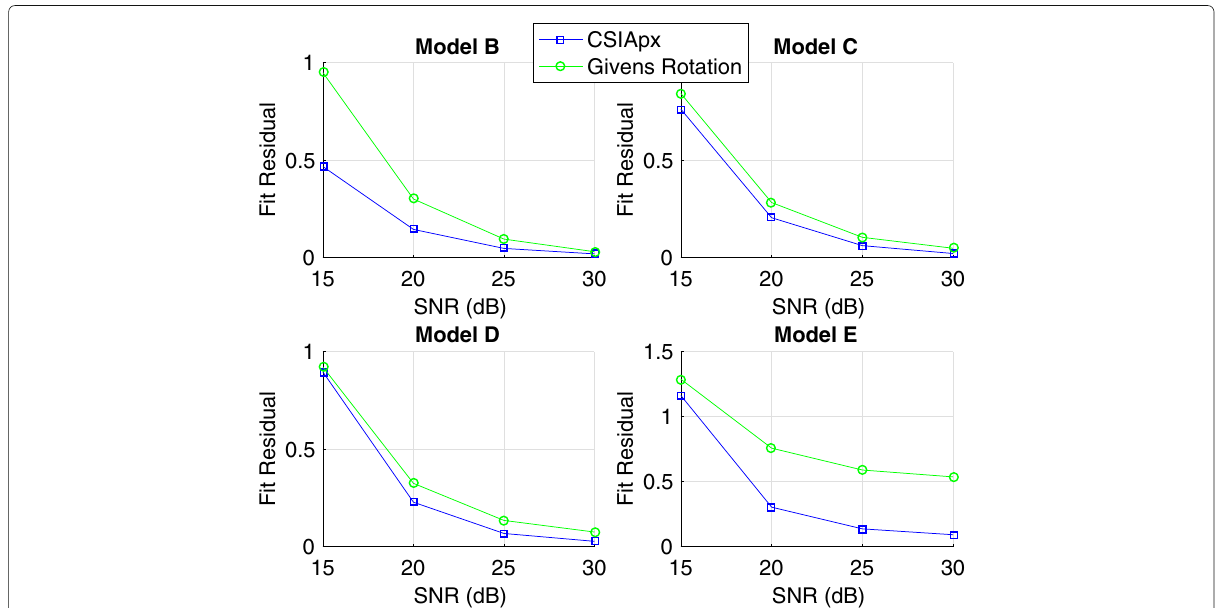
Fig. 14 Fit residual comparison with Givens rotation. The comparison between the fit residual achieved by CSIApx and Givens rotation is shown when running on the synthesized CSI data at four SNR values 15 dB, 20 dB, 25 dB, and 30 dB